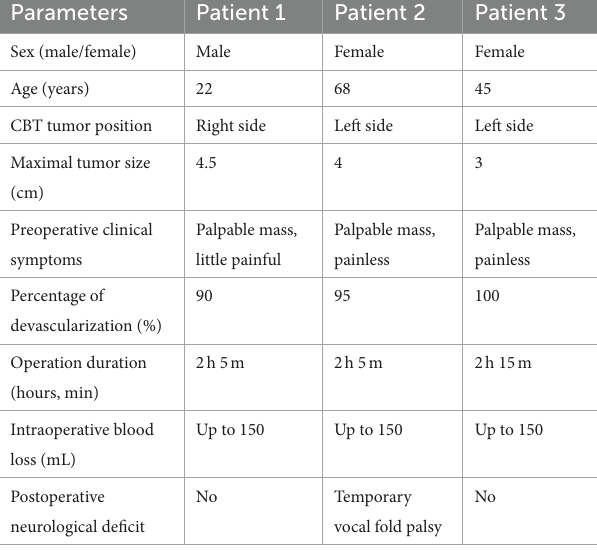
TABLE 1 Preoperative and postoperative characteristics of all patients. Parameters